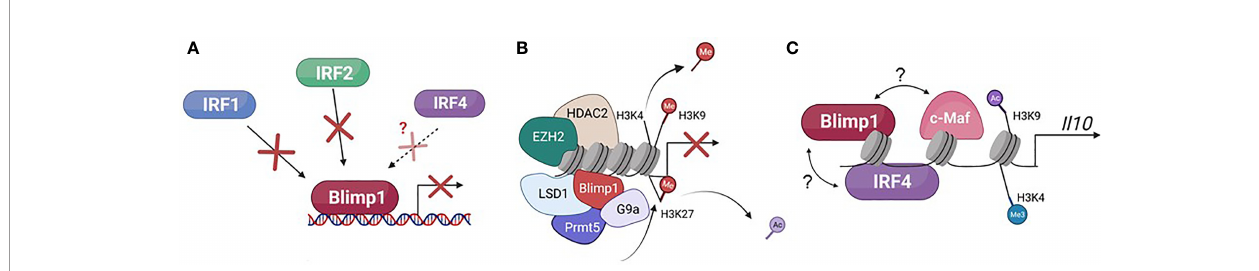
FIGURE 2 | Described mechanisms of gene regulation by Blimp1. (A) Blimp1 can repress target gene transcription by competing with transcriptional activators, speci fi cally IRF1 and IRF2, and potentially IRF4, for binding to different target genes. (B) Blimp1 can repress target gene transcription by recruiting chromatin- modifying co-factors that promote suppressive chromatin structure, notably HDAC2 (histone de-acetylase 2, de-acetylates H3), G9a (lysine histone methyltransferase, H3K9 and H3K27), EZH2 (methylates H3K27), LSD1 (histone lysine demethylase, H3K4 and H3K9), and Prmt5 (di-methylates arginine residues, H2A and H4). (C) Blimp1 has been shown to activate Il10 transcription by binding directly to its locus, in a cooperative manner with IRF4, and mediating chromatin modi fi cations that facilitate transcription (tri-methylation of H3K4 and acetylation of H3K9). Blimp1 has also been shown to cooperate with c-Maf to induce Il10 transcription in T cells, but whether or not they physically bind with each other is